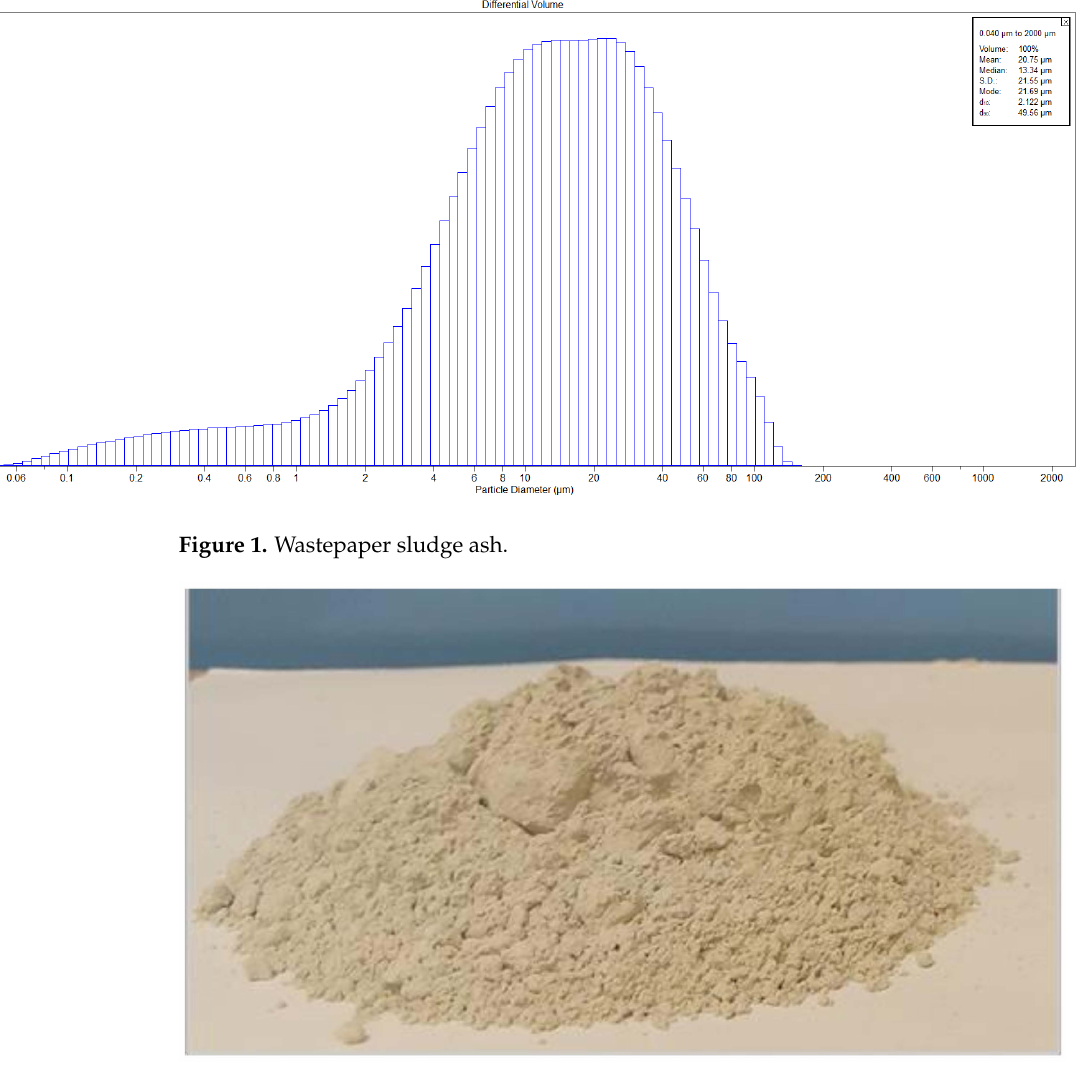
Figure 2. Particle size distribution for wastepaper sludge ash (WPSA).